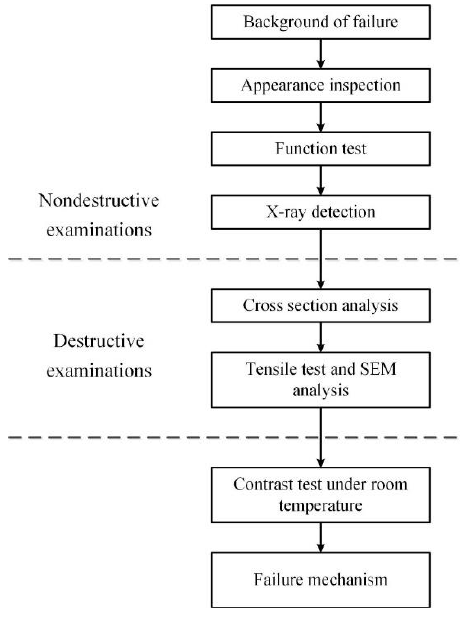
Figure 2. The process of failure analysis.